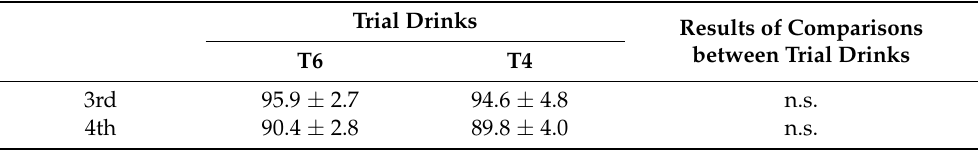
Table 3. Mean power value assessment and statistical analysis results (experiment 2). Trial